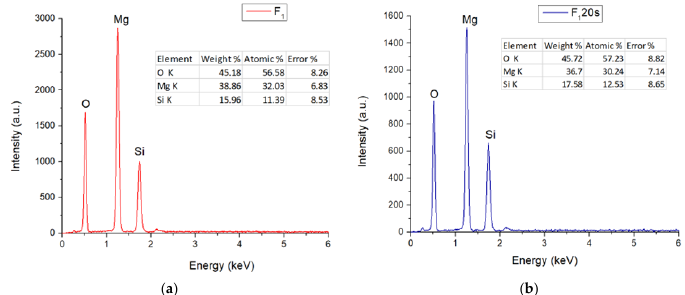
Figure 4. EDS spectra for: ( a ) F 1 ; ( b ) F 1 20s samples.